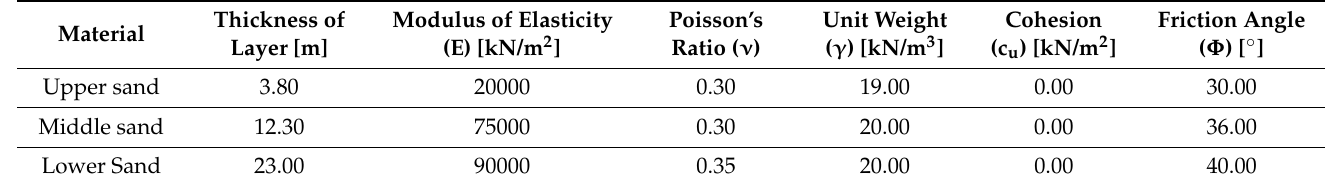
Table 3. Properties of soil materials.